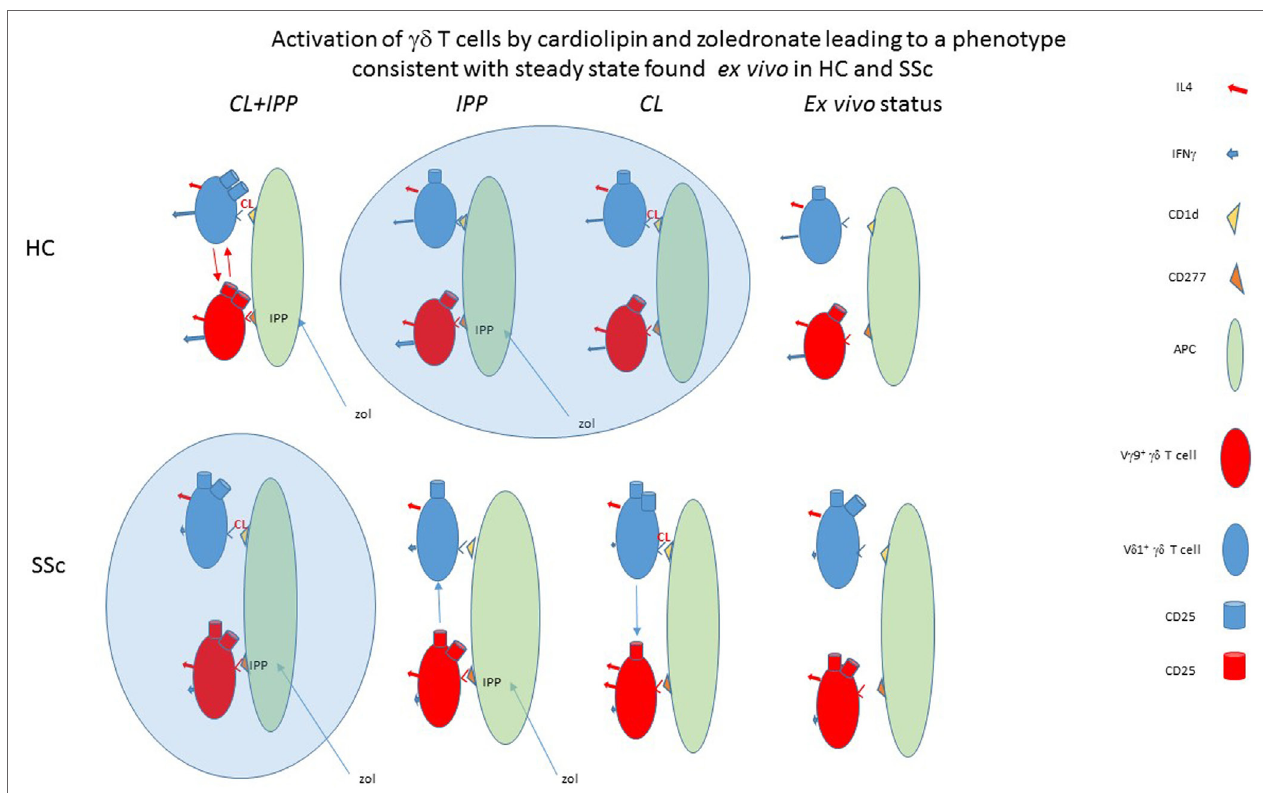
FigUre 7 | Model of differential cardiolipin (CL) and zoledronate (zol) effects in systemic sclerosis (SSc) patients and healthy controls (HC). The cartoon shows V δ 1 + or V γ 9 + T cells interacting with an APC bearing CD1d and CD277, in the presence or absence of CL and/or isopentenyl pyrophosphate (IPP) induced by zol, respectively, presented by CD1d or CD277. Response of the antigen-triggered γδ T cells to antigen stimulation is reflected by expression of CD25 and release of cytokines. Magnitude of response is represented by the number of CD25 symbols or size of the cytokine arrow, using HC as the standard. The phenotype of ex vivo cultured cells without any stimulation is depicted on the right as indicated. As seen, the ex vivo non-stimulated phenotype is consistent with concurrent dual stimulation (CL and zol) of the V δ 1 + and V γ 9 + T cells in SSc and with each separately in